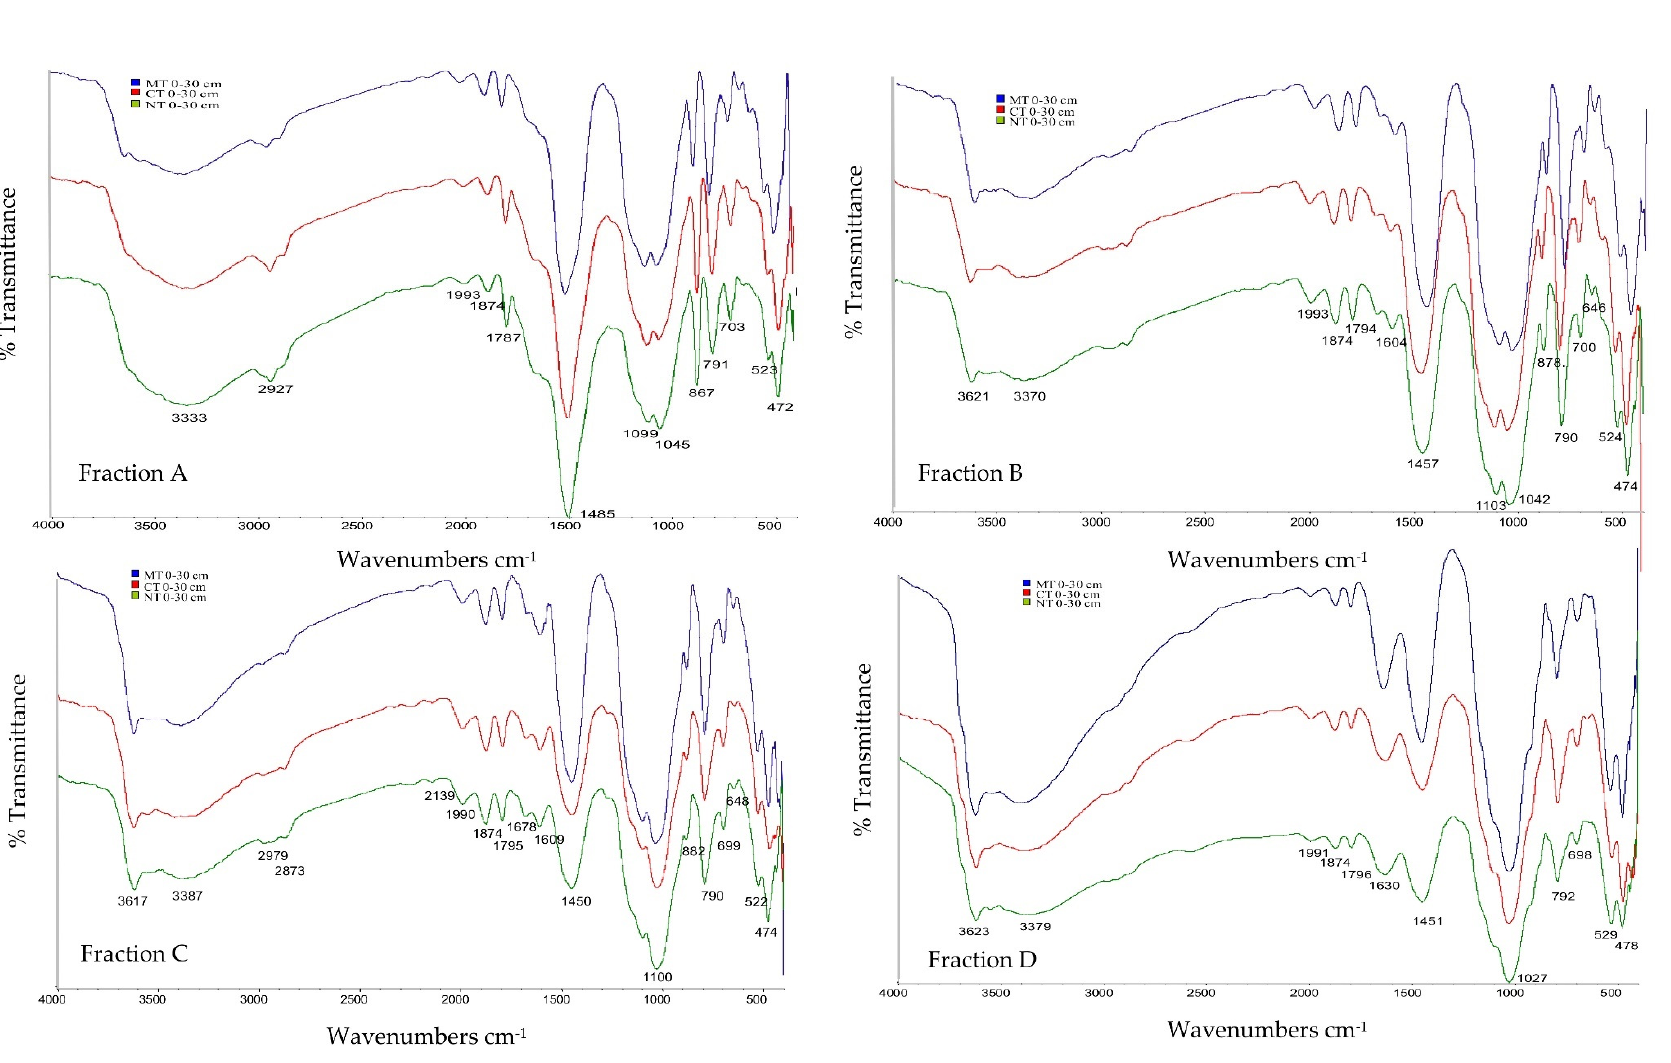
Figure 5. Diffuse reflectance infrared Fourier transform spectra of all soil fractions (A, B, C, and D) isolated from different tillage treatments at 0–30 cm of depth.